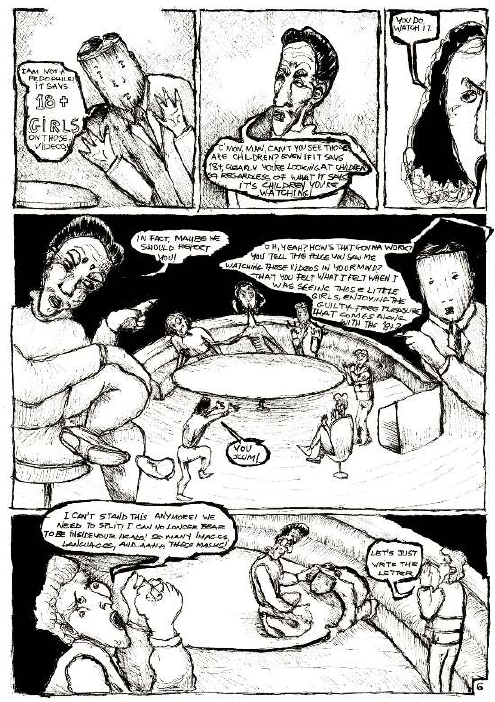
Figure 7: Plate 6, Diamond Princess II